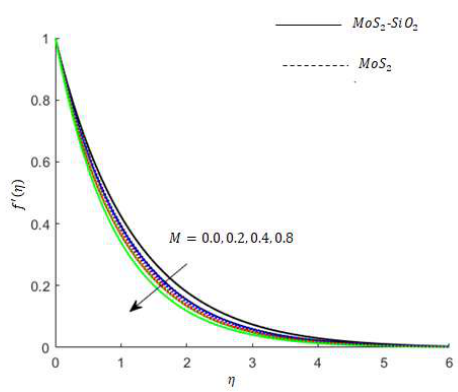
Figure 6. Variation in velocity for β when Pr = 2.36, Ec = 0.01, Sc = 0.8, Sr = 0.1, Bi = 0.05, and β ∗ = 0.1.